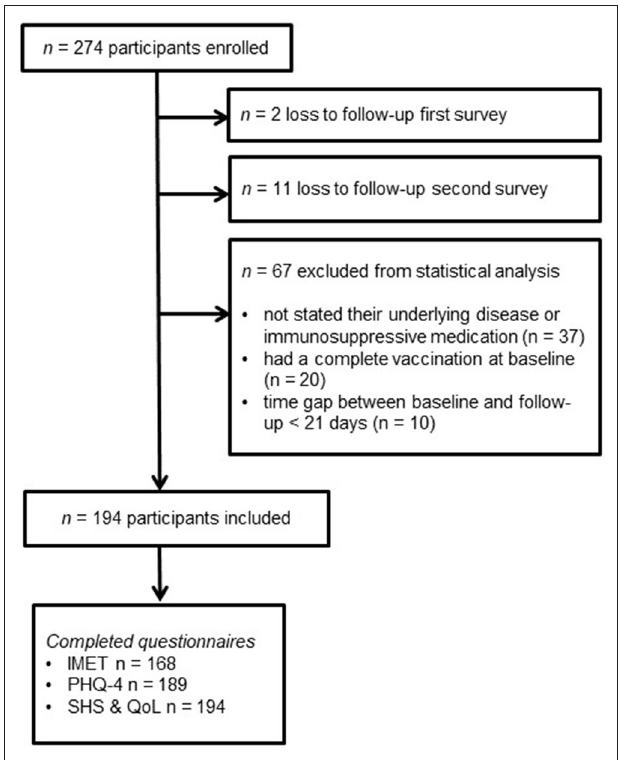
FIGURE 1 | Flowchart participants’ exclusion from analysis. Legend: IMET, Index for the Assessment of Health Impairments; PHQ-4, Patient Health Questionnaire-4; QoL, Quality of Life; SHS, Subjective health